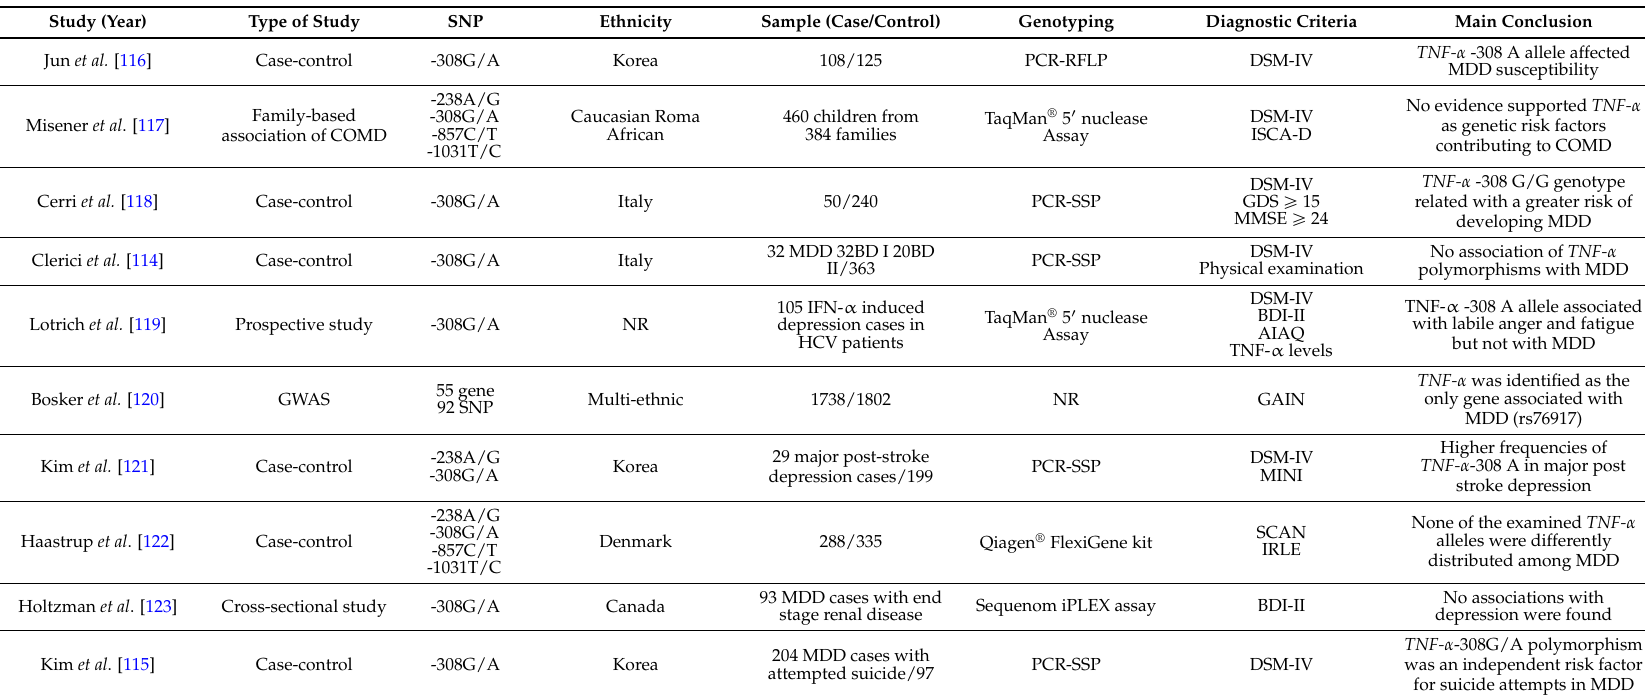
Table 1. Studies examining the relative contribution of tumor necrosis factor (TNF)- α gene polymorphisms on